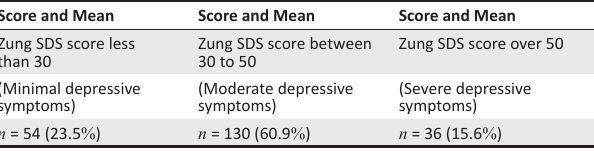
TABLE 2: Prevalence of depressive